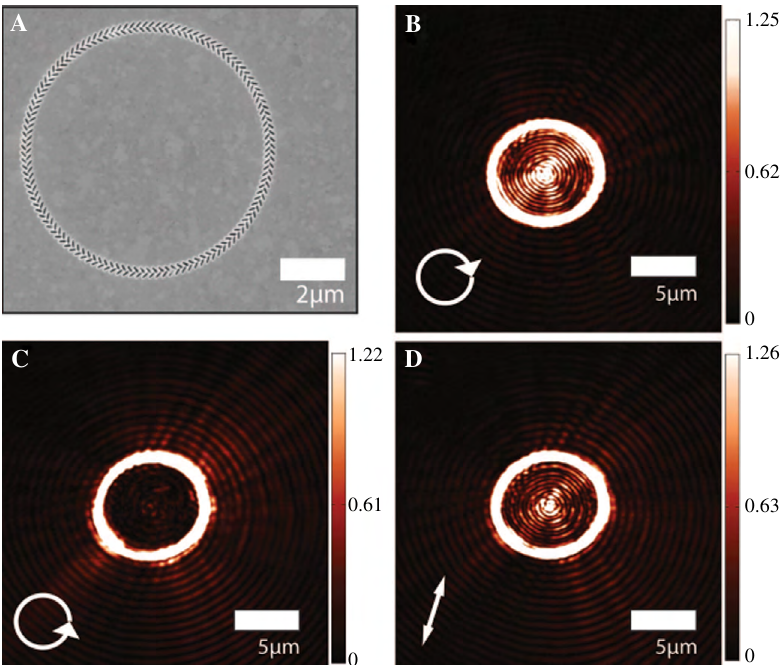
Figure 20 (A) SEM image of a circular coupler. NSOM images of the coupler under (B) RHC, (C) LHC and (D) linearly polarized light. The state of incident polarization is indicated by white arrows. Adapted from Ref.